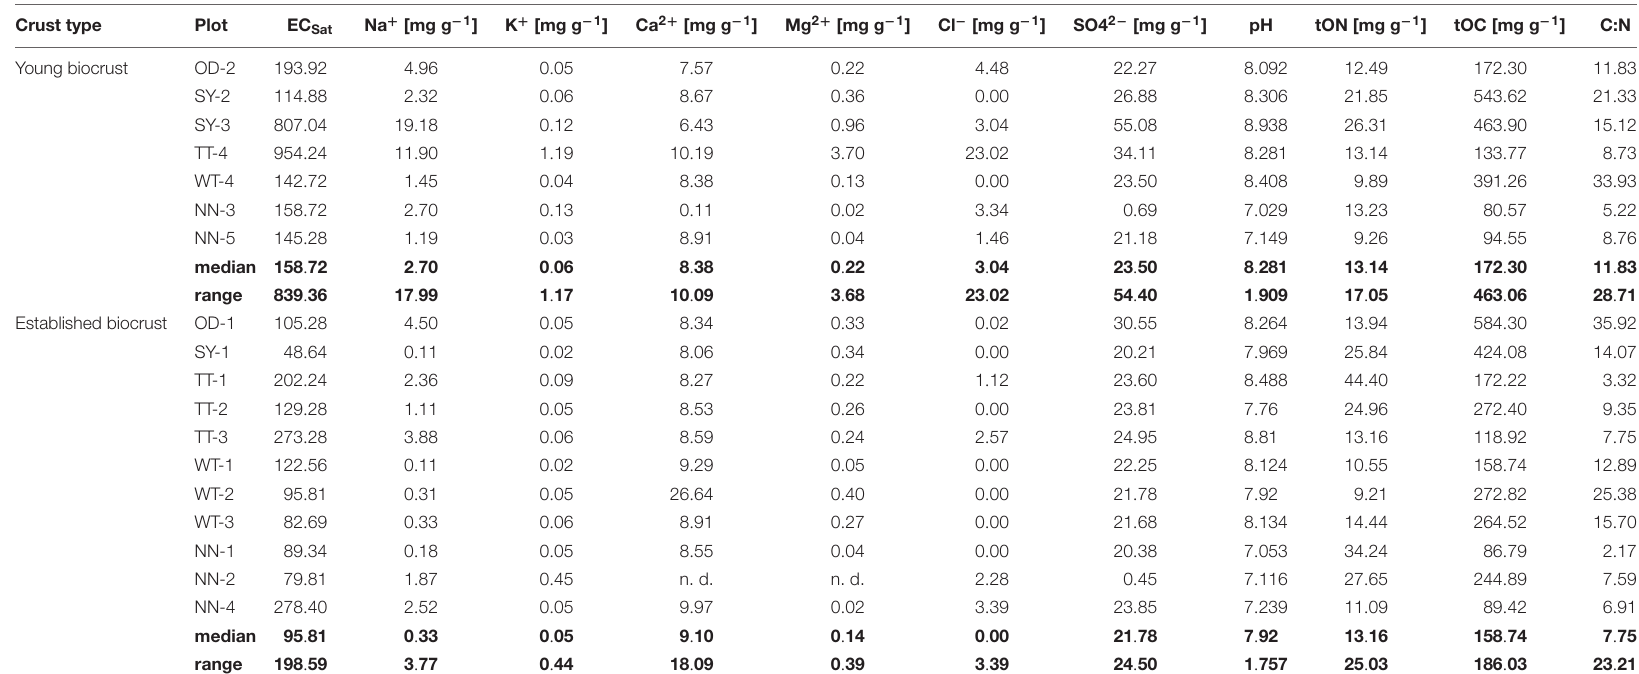
TABLE 2 | Characterization of soil samples from young and established biocrusts in potash tailings pile areas (OD: Oedesse; SY: Shreyahn; TT: Teutschenthal; WT: Wietze; NN: not further described). Crust